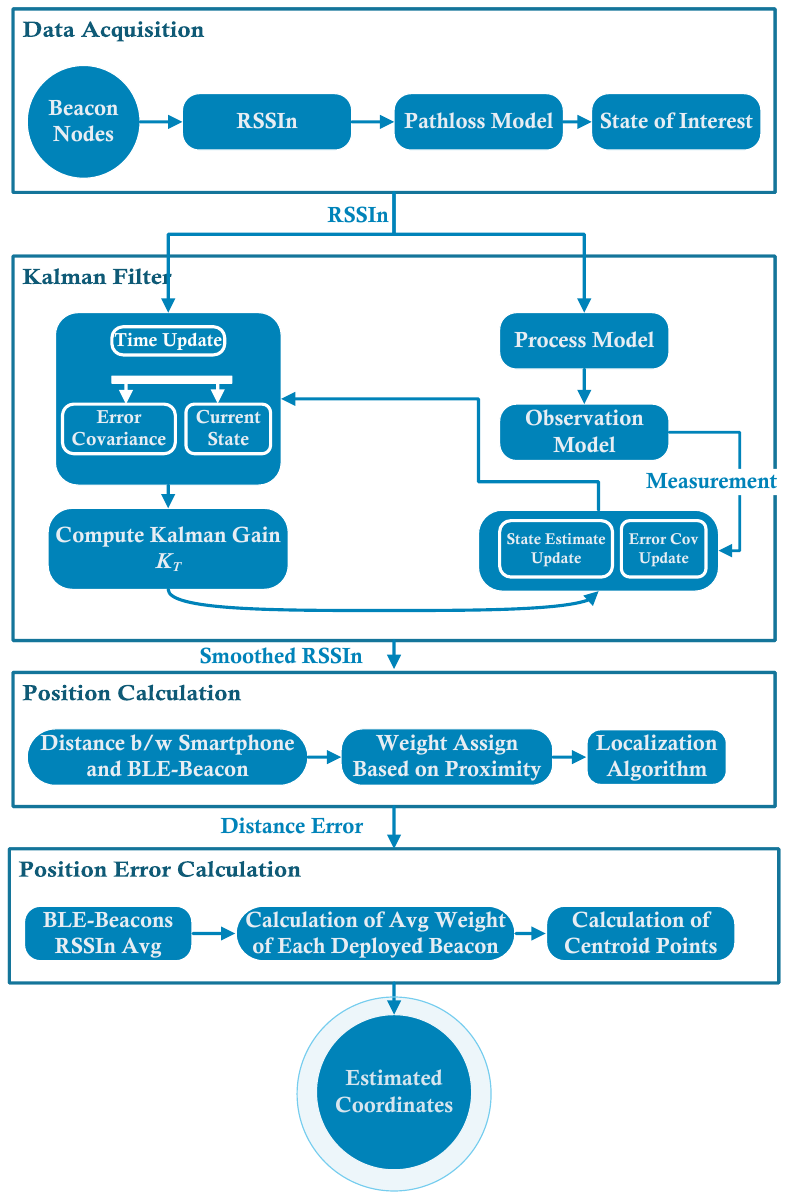
Figure 5. BLE-beacon Compensation Mechanism Based on Kalman Filter and